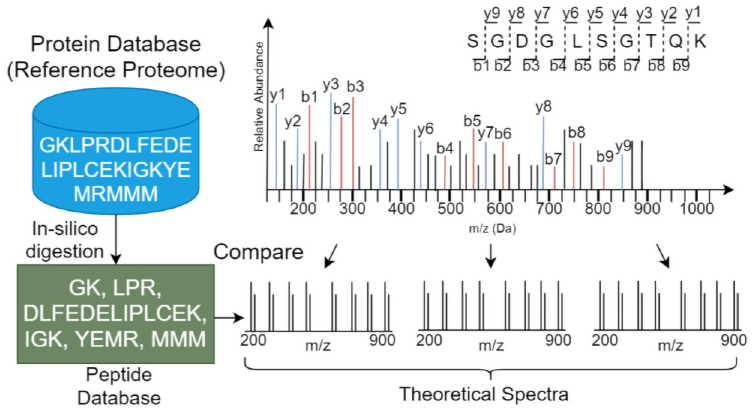
Fig 2. A generic proteomics flow. In-silico digestion of the protein database is performed to generate peptides. These peptides are then converted to the theoretical spectra and compared against the experimental spectra.